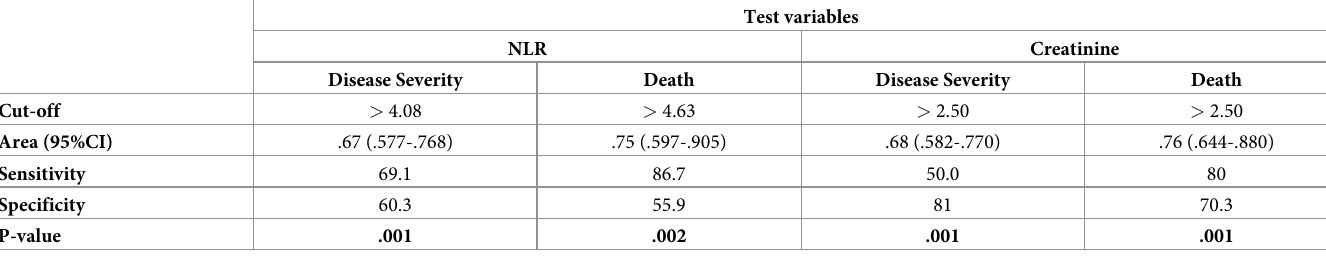
Table 5. Creatinine and NLR as predictor of disease severity and mortality of